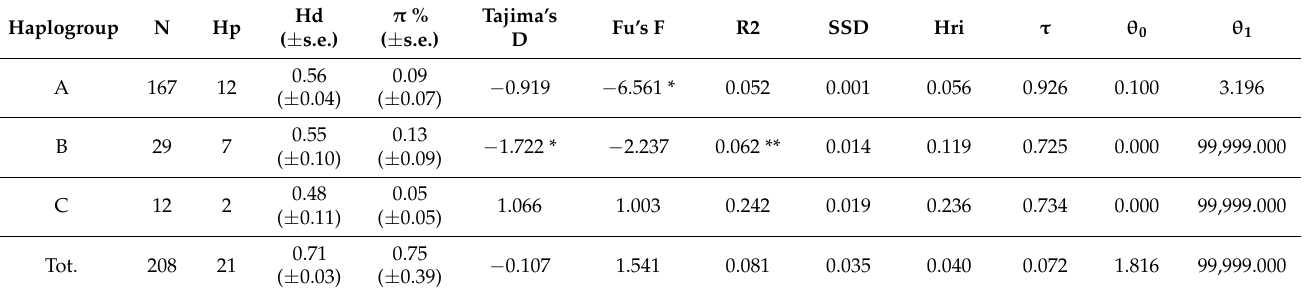
Table 2. Summary of genetic variation, neutrality test and mismatch distribution parameters for the mitochondrial control region (CR) for each haplogroup and all